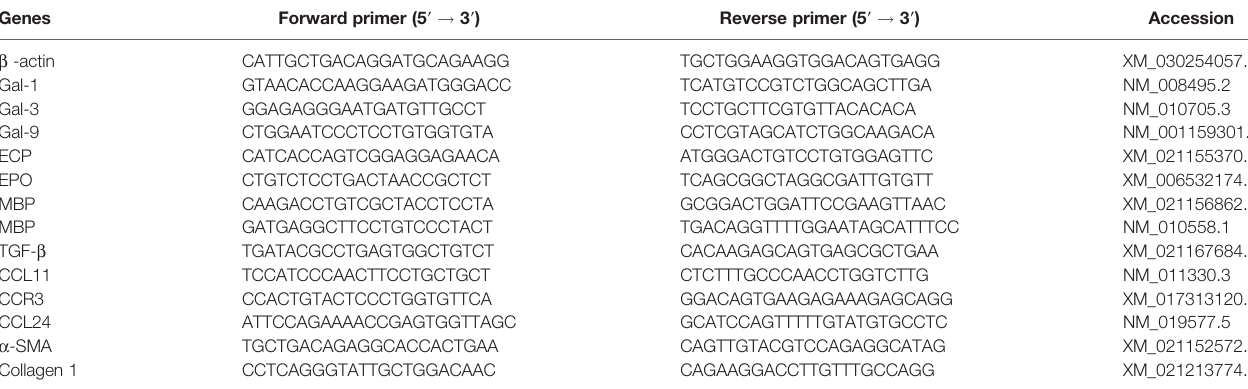
TABLE 1 | Primer sequences of genes used for quantitative real-time reverse transcription-polymerase chain reaction assays.